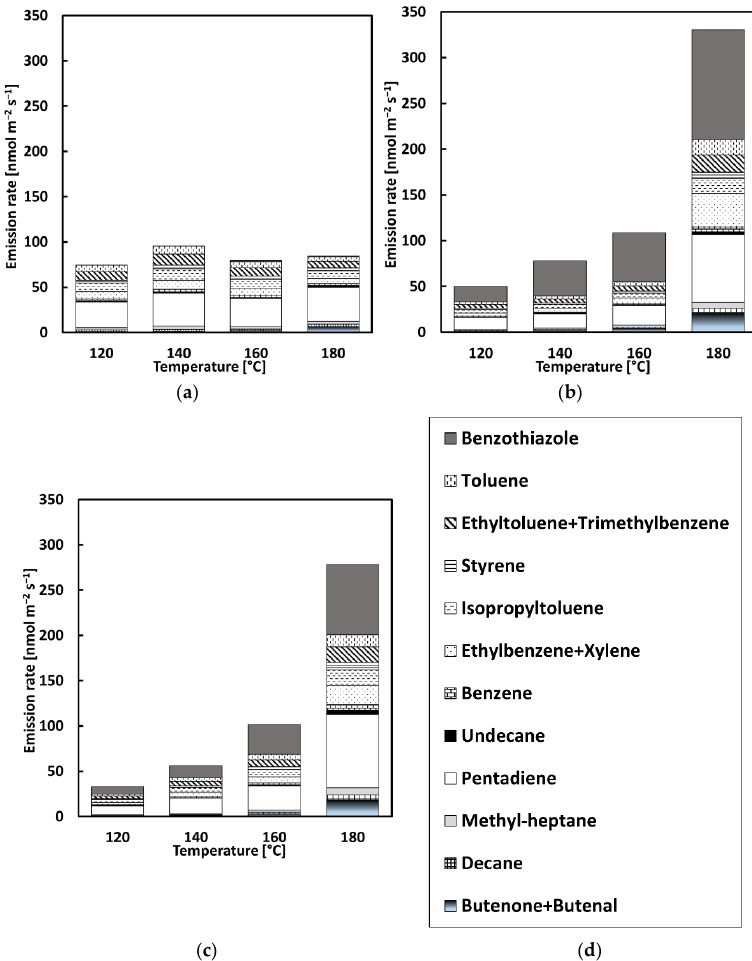
Figure 8. Distribution of VOC emissions with a step-by-step increase in temperature: ( a ) REF, ( b ) CRMB1, ( c ) CRMB2, and ( d ) legend.